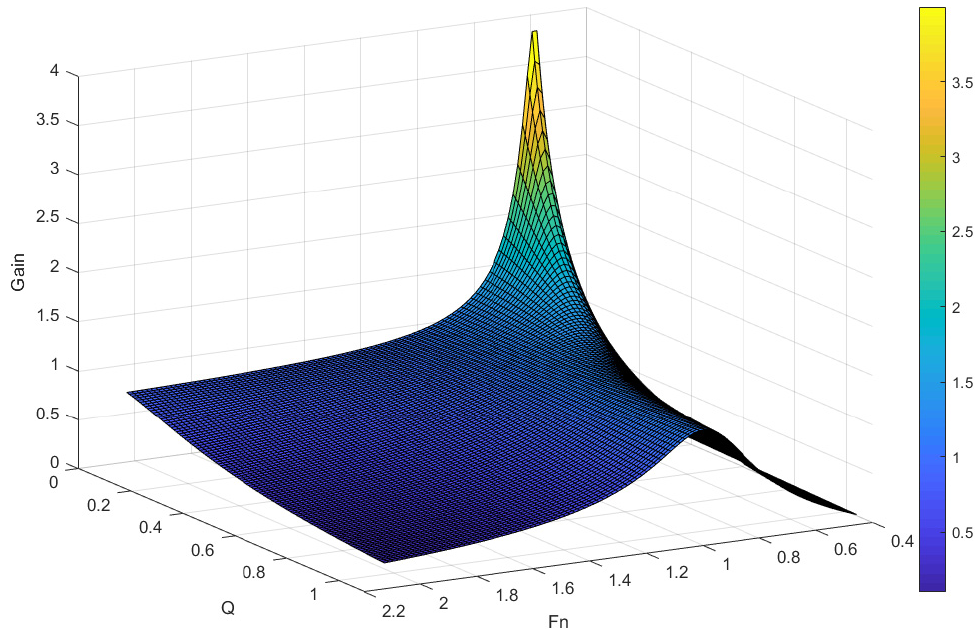
Figure 2. LLC resonant converter voltage gain according to FHA